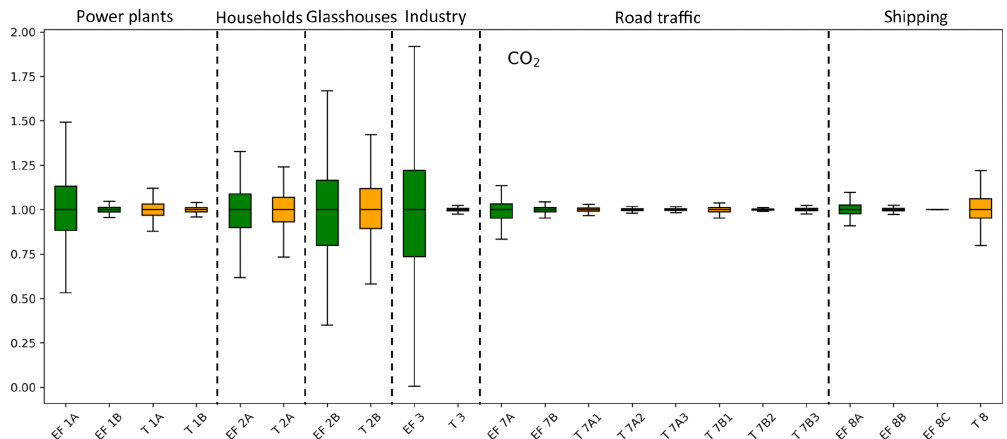
Figure 9. Box plots showing the uncertainty in the CO 2 emissions from power plants (1A + 1B), households (2A), glasshouses (2B), industry (3), road traffic (7A + 7B), and shipping (8A + 8B + 8C) caused by individual parameters affecting that sector. Uncertainty is represented as the spread in daily (normalized) emissions from each ensemble member ( N = 500) for a randomly chosen day. EF refers to an emission factor (green bars) and T to a time profile (orange bars). (Sub)sectors are indicated with their short names as summarized in Table 1. Note that the time profiles of road traffic emissions are specified per road type (1 = highway, 2 = main road, 3 = urban road). Minor parameters that have very small impacts on CO 2 emissions are not shown here (23 out of